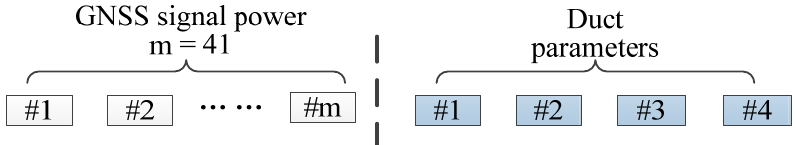
Figure 13. Schematic of data composition.